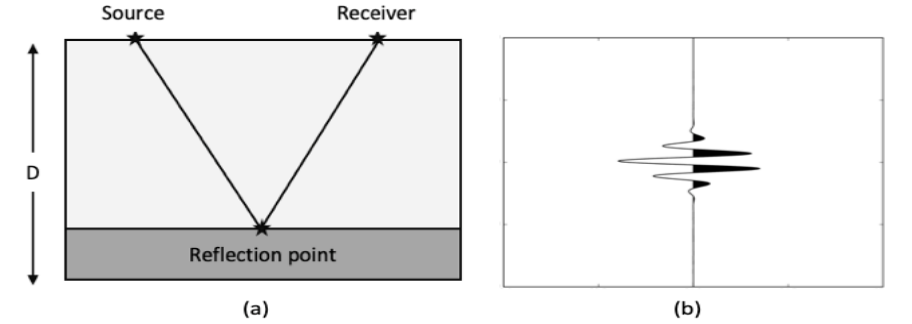
Figure 1. (a) Shows the typical travel path of a seismic wave from source to the receiver via subsurface, (b) a single seismic trace with energy in